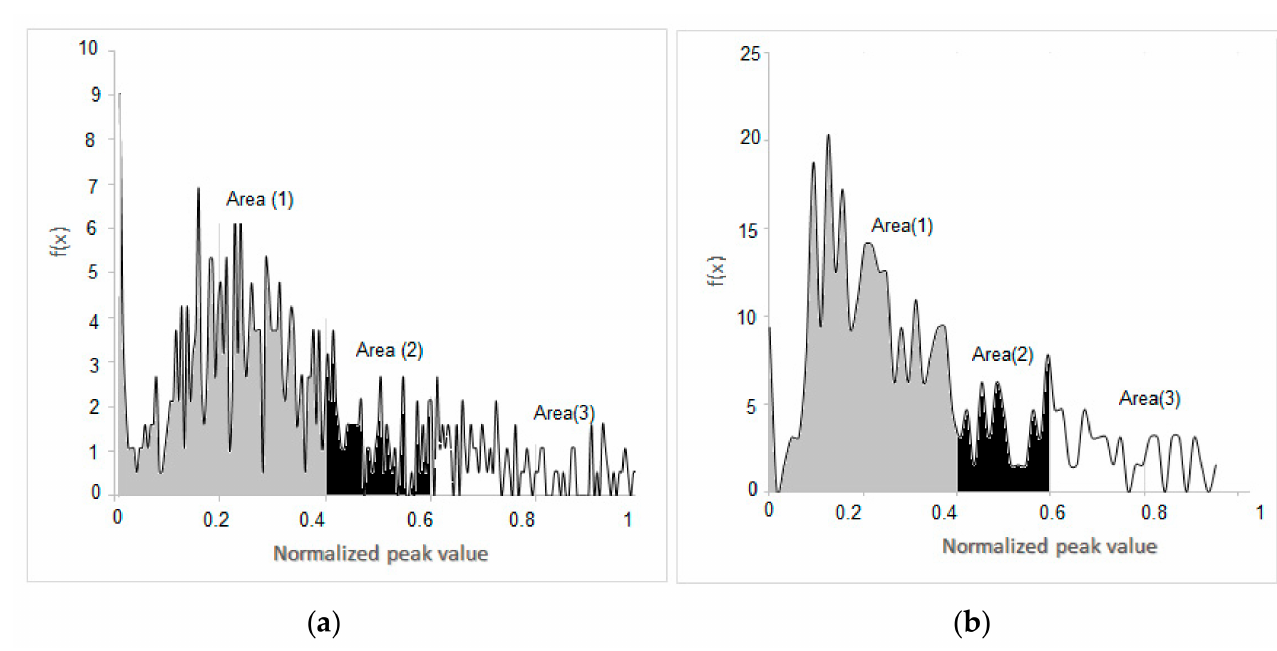
Figure 8. Frequency (f(x)) for normalized peak values of the preprocessed IE signals ( a ) sound area and ( b ) defect area.